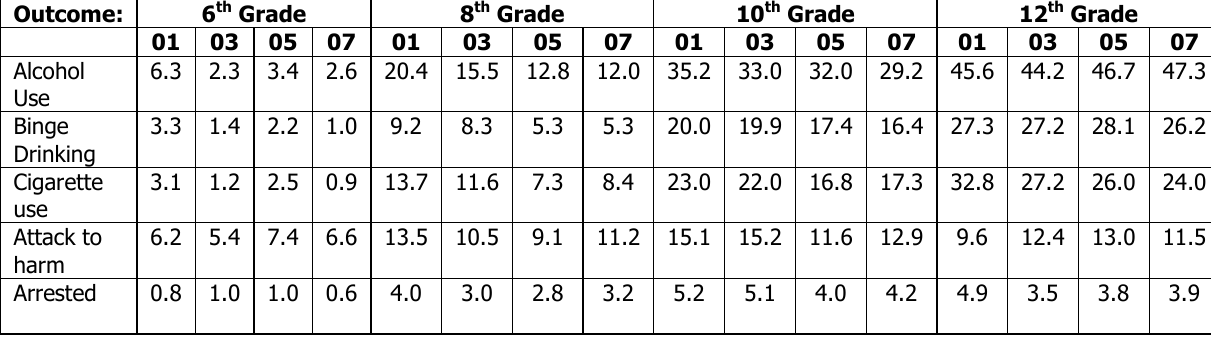
Outcome variable percentages by grade level (30-day prevalence